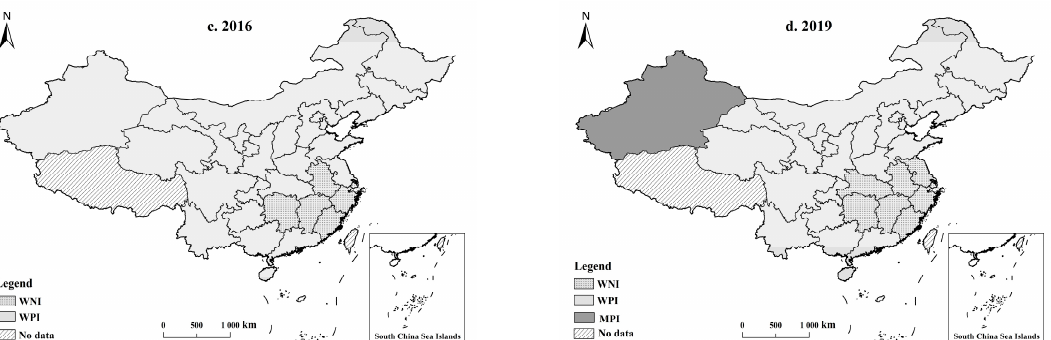
Figure 6. Spatial distribution of the regression coefficients of GDP per capita: ( a ) Spatial distribution of the regression coefficients of GDP per capita in 2010; ( b ) Spatial distribution of the regression coefficients of GDP per capita in 2013; ( c ) Spatial distribution of the regression coefficients of GDP per capita in 2016; ( d ) Spatial distribution of the regression coefficients of GDP per capita in 2019. 5.